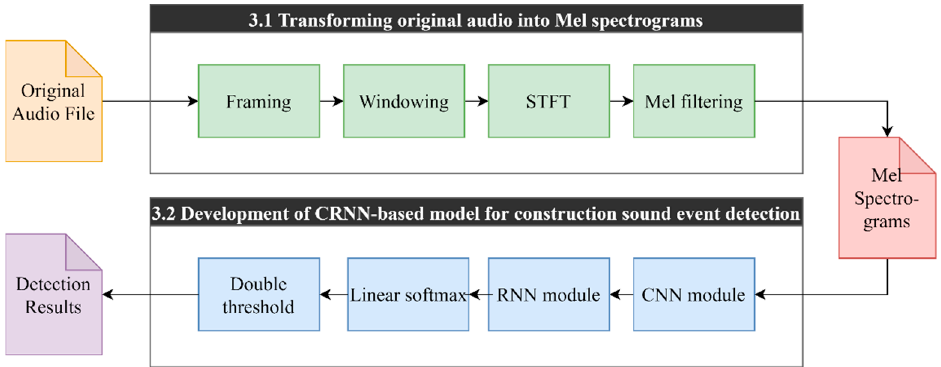
Figure 3. The process of the proposed methodology.